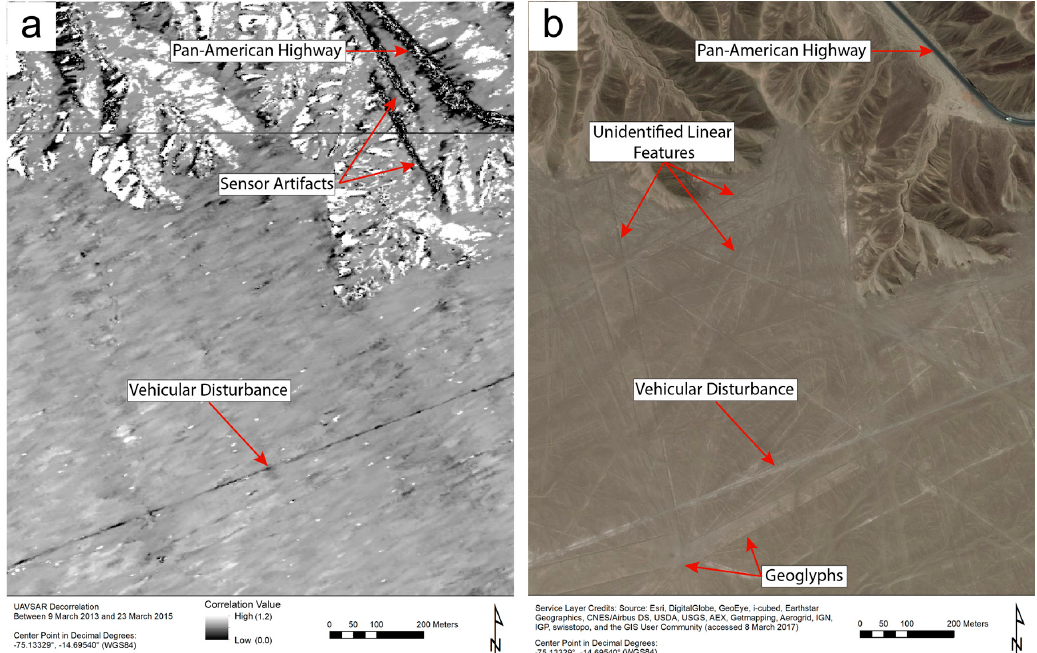
Figure 4. The correlation image in ( a ) indicates that only one of the linear features visible in ( b )—some of which may be not trails or roads, but geoglyphs—was substantially disturbed between UAVSAR flights (without ground verification, it is difficult to confidently classify the unidentified linear features). Sensor artifacts, visible in ( a ), are due to interference with radar waves by fast-moving vehicles on the highway and do not correspond to any physical features or changes on the